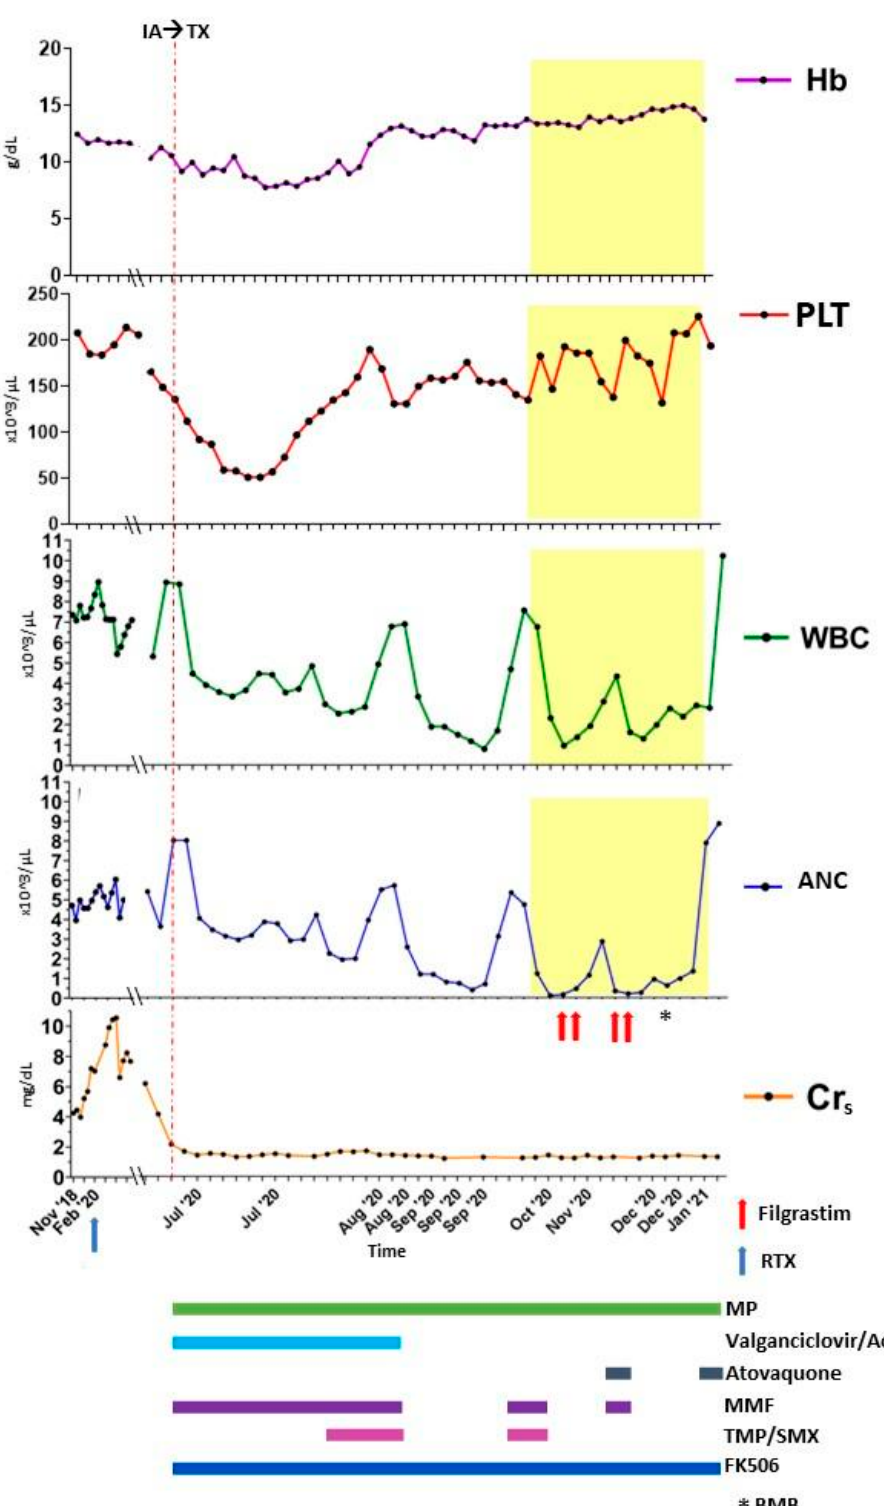
Figure 1. Clinical and biochemical timeline of case report, WBC: white blood cells, PLT: platelets, ANC: absolute neutrophil count, Crs: serum creatinine, MP: methylprednisolone, MMF: mycophenolate mofetil, TMP/SMX: trimethoprim/sulfamethoxazole, FK506: tacrolimus, RTX: rituximab, BMB: bone marrow biopsy, TX: transplantation, IA: immunoadsorption.